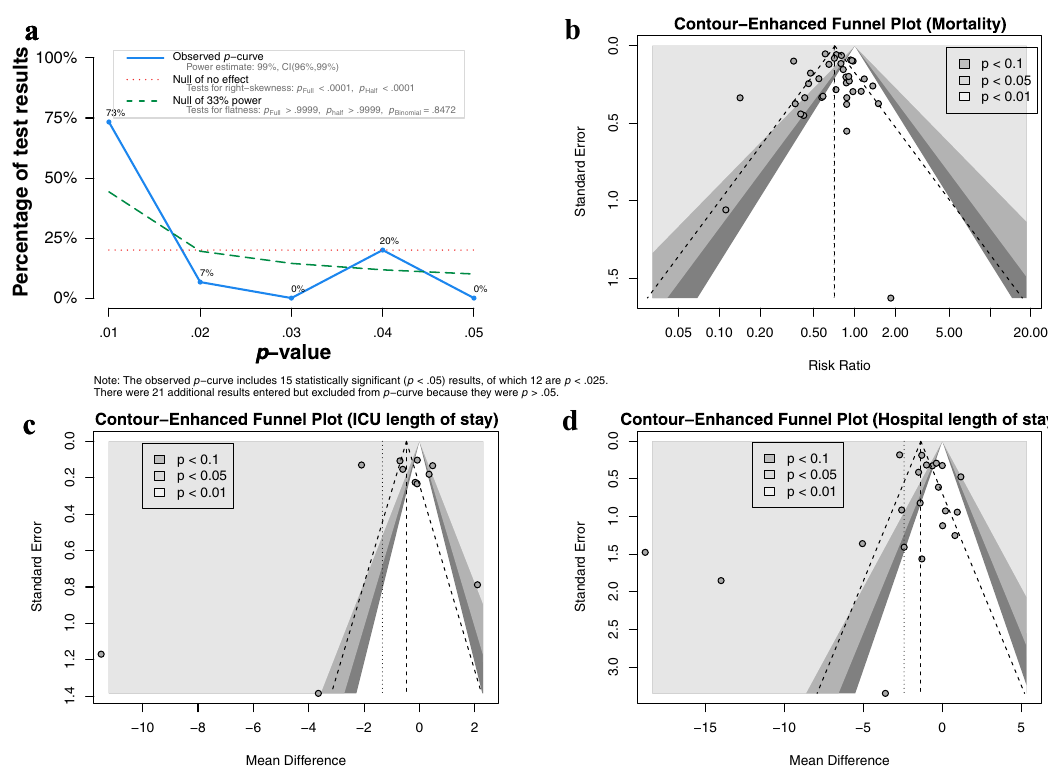
Fig. 6 Assessment of publication bias. a Visual inspection of the p-curve plot shows a right-skewed distribution with 73% of the p -values between 0 and 0.01 and only 20% of p -values between 0.03 and 0.05. The statistical tests against the null hypothesis that all of the signi fi cant p-values are false positives are highly signi fi cant. Thus, at least some of the p-values are likely to be true positives. Finally, the power estimate is very high, 99%, with a tight con fi dence interval ranging from 96% to 99%. Somewhat redundant with this information, the p-curve also provides a signi fi cant test for the hypothesis that power is less than 33%. This test is not signi fi cant, which is not surprising given the estimated power of 99%. The contour-enhanced funnel plots showed signi fi cant levels area at 0.1, 0.05, and 0.01 for b mortality, c ICU length of stay, and d hospital length of stay. Some studies appeared to be missing in areas of high statistical signi fi cance, thus it is possible that the asymmetry is not due to publication bias. ICU intensive care hospital. The prediction algorithm was classi fi ed into rule-based or ML- based methods. The rule-based method referred to those using existing sepsis diagnostic criteria for the warning of the presence of sepsis. Two authors independently extracted data. Any con fl icting results were solved